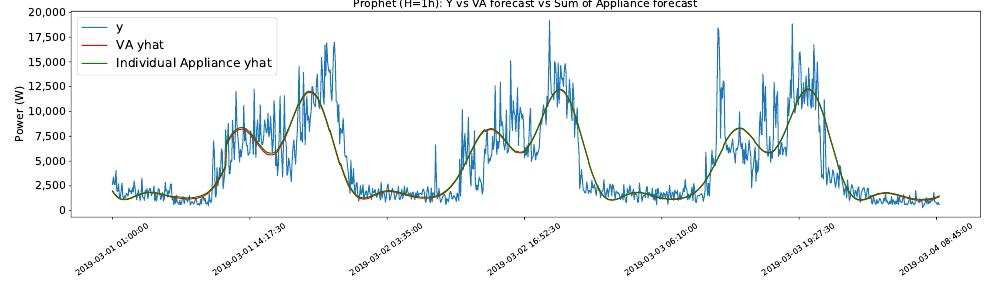
Figure 4. Prophet (H = 1 h) VA forecast vs sum forecast of the